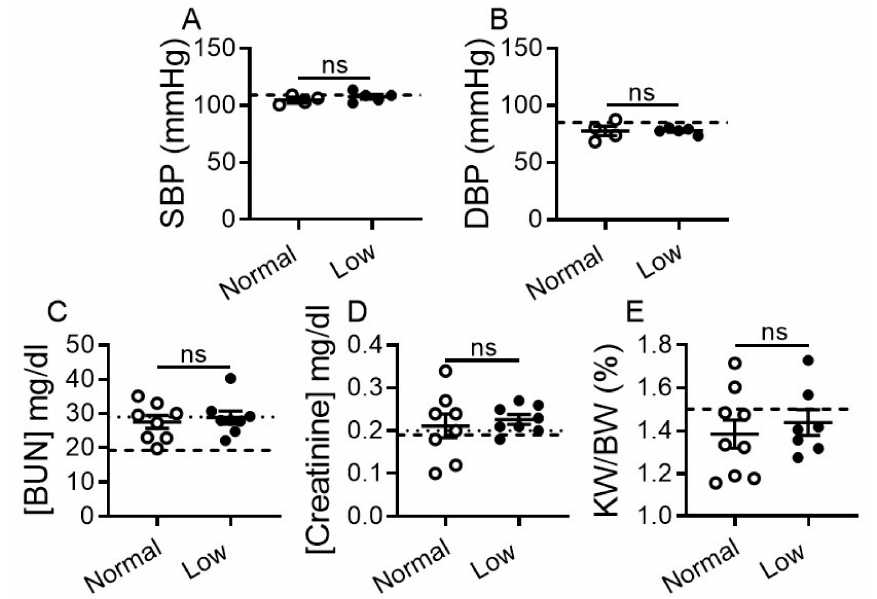
Figure 5. Dietary sodium restriction does not affect blood pressure and renal chemistry values in mice with DCM. ( A ) Systolic blood pressure (SBP). ( B ) Diastolic blood pressure (DBP). Three to five consecutive recordings were used and graphs were plotted as mean ± SEM. DCM mice on NSD n = 4, on LSD n = 5; WT mice (dashed line, n = 8). ( C,D ) Plasma levels of blood ( C ) urea nitrogen (BUN), and ( D ) creatinine. Number of DCM mice n = 8 per group. Dotted lines indicate upper limits of normal range of BUN and creatinine, and dashed lines represent WT control levels ( n = 8). ( E ) Kidney weight to body weight ratio (KW/BW). Number of DCM mice n = 7–9 per group. WT control mice (dashed line, n = 9). Data are presented at 17 weeks of age, as mean ± SEM. ns = non-significant as assessed by one-way ANOVA with Newman-Keuls multiple comparison test ( A , B , E ) or by unpaired t -test ( C , D